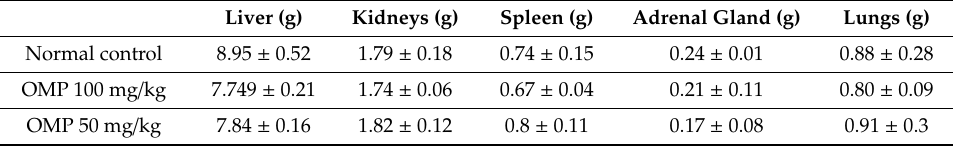
Table 2. E ff ect of subacute administration of OMP on the relative weight of organs.